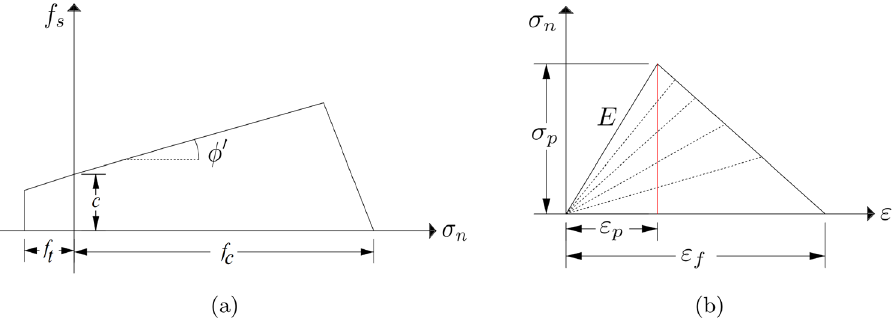
Figure 4. Fracture mechanism: ( a ) Mohr–Coulomb failure model with tension cut, and ( b ) implemented bi-linear softening